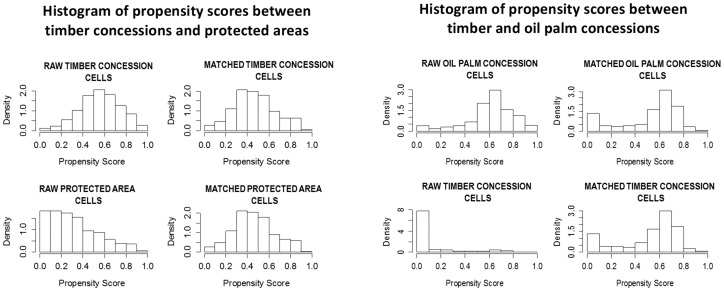
Histogram distribution of propensity scores before and after matching between timber concessions and protected areas (left panel); and between timber and oil palm concessions (right panel).